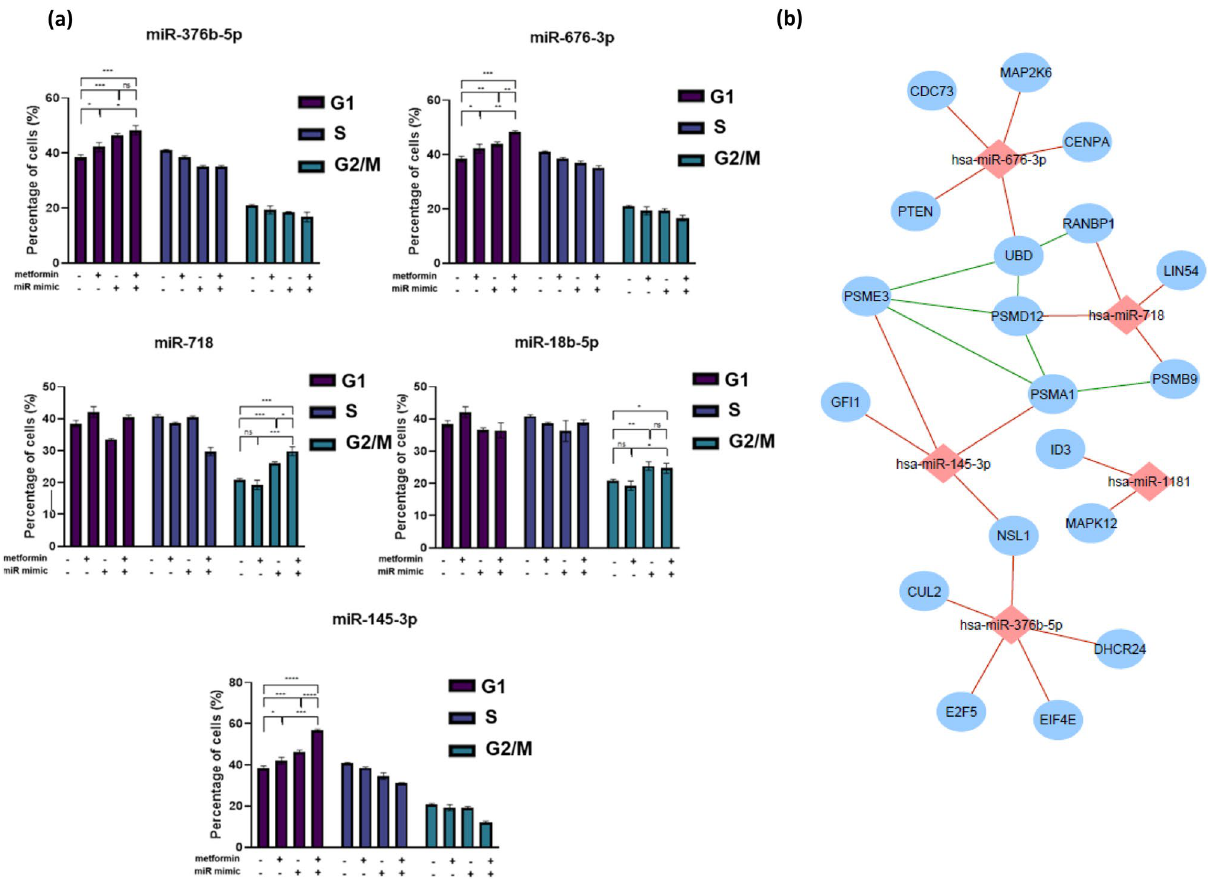
Figure 6. Cell cycle distribution of HCT116 cells after transfection with sensitizing miRNAs and treatment with metformin or control medium for 96 h ( a ) and the miRNA-based sub-network of putative target genes associated with cell cycle ( b ). ( a ) Histograms showing the percentage of HCT116 cells transfected with miR- 18b-5p, miR-145-3p, miR-376b-5p, miR-676-3p and miR-718 mimics and treated with 2.5 mM metformin for 72 h in G0/G1, S, and G2/M phases, compared with cells in control medium. A “–” miRNA mimic status indicates transfection with NC negative control mimics. Results are expressed as mean ± SD of 3 replicates and the statistical significance is indicated with asterisks (ns P > 0.05, *P ≤ 0.05, **P ≤ 0.01, ***P ≤ 0.001, ****P ≤ 0.0001). ( b ) This is an organic layout of the integrated network associated putative genes organised in cell cycle associated ontologies acquired by Targetscan predition algorithm and NetworkAnalyst-Panther/Slim GO analysis. The miRNA-gene interactions are shown as red lines while gene–gene interactions are green. The blue and red nodes represent predicted taget genes and miRNAs,